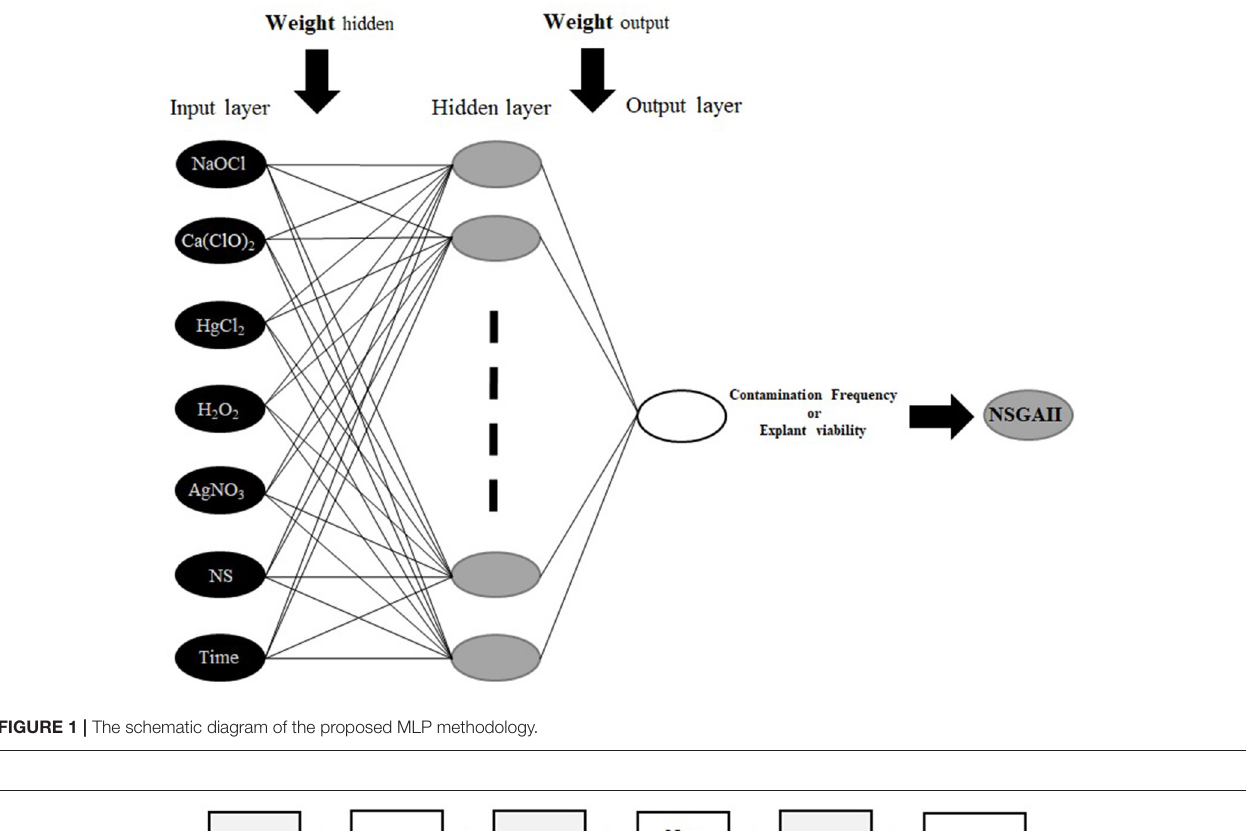
FIGURE 1 | The schematic diagram of the proposed MLP methodology.